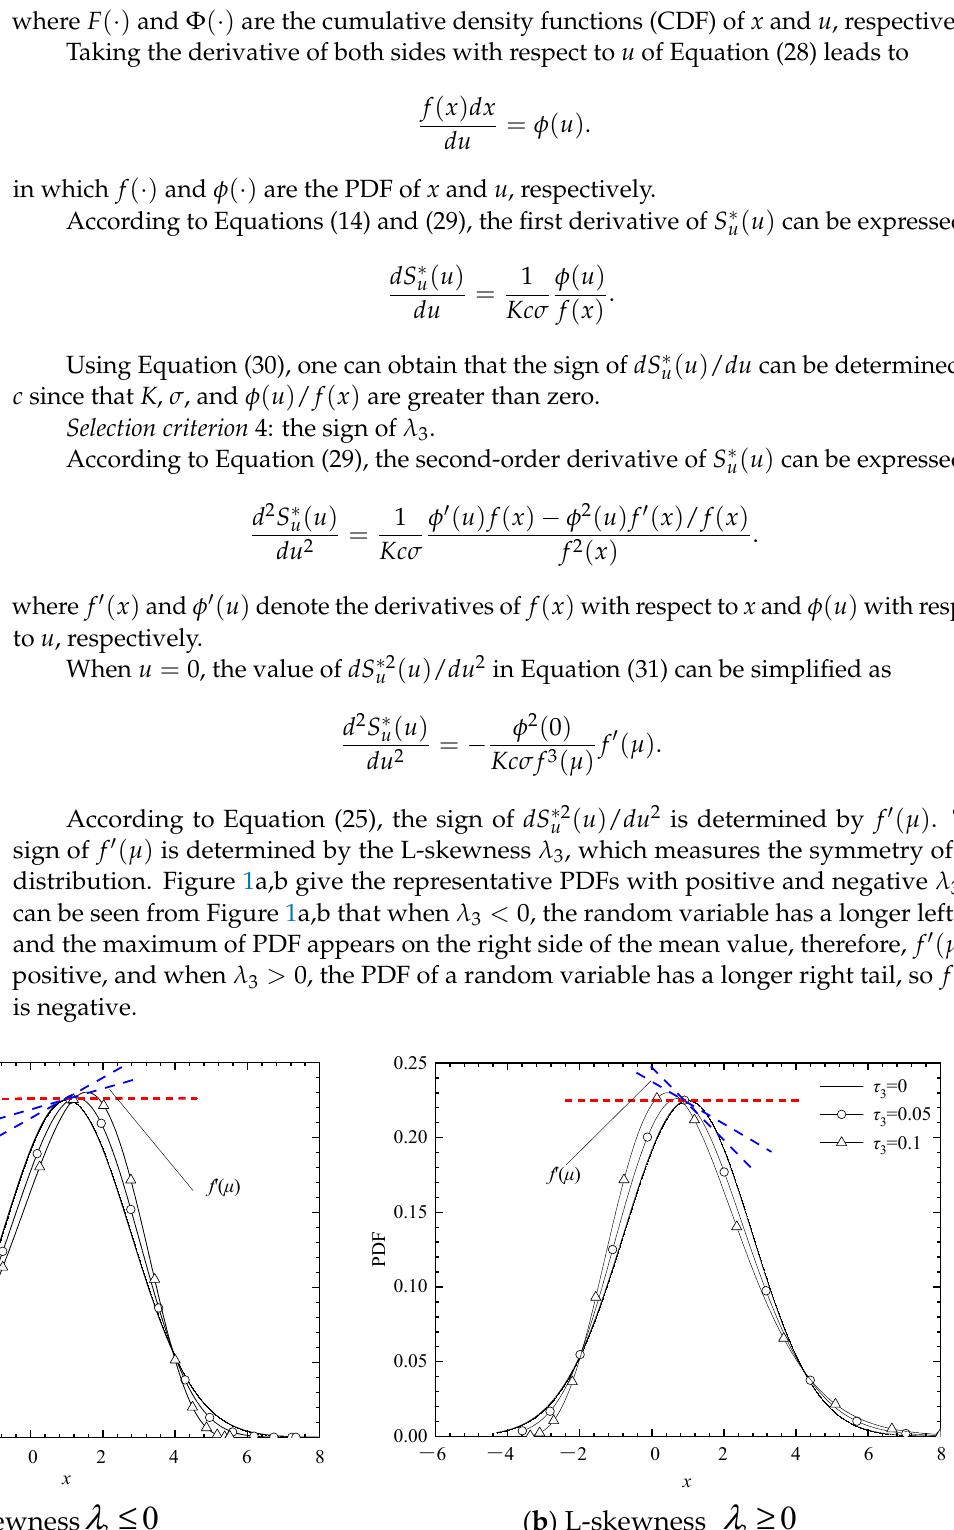
Figure 1. The relationship between the sign of ( ) f